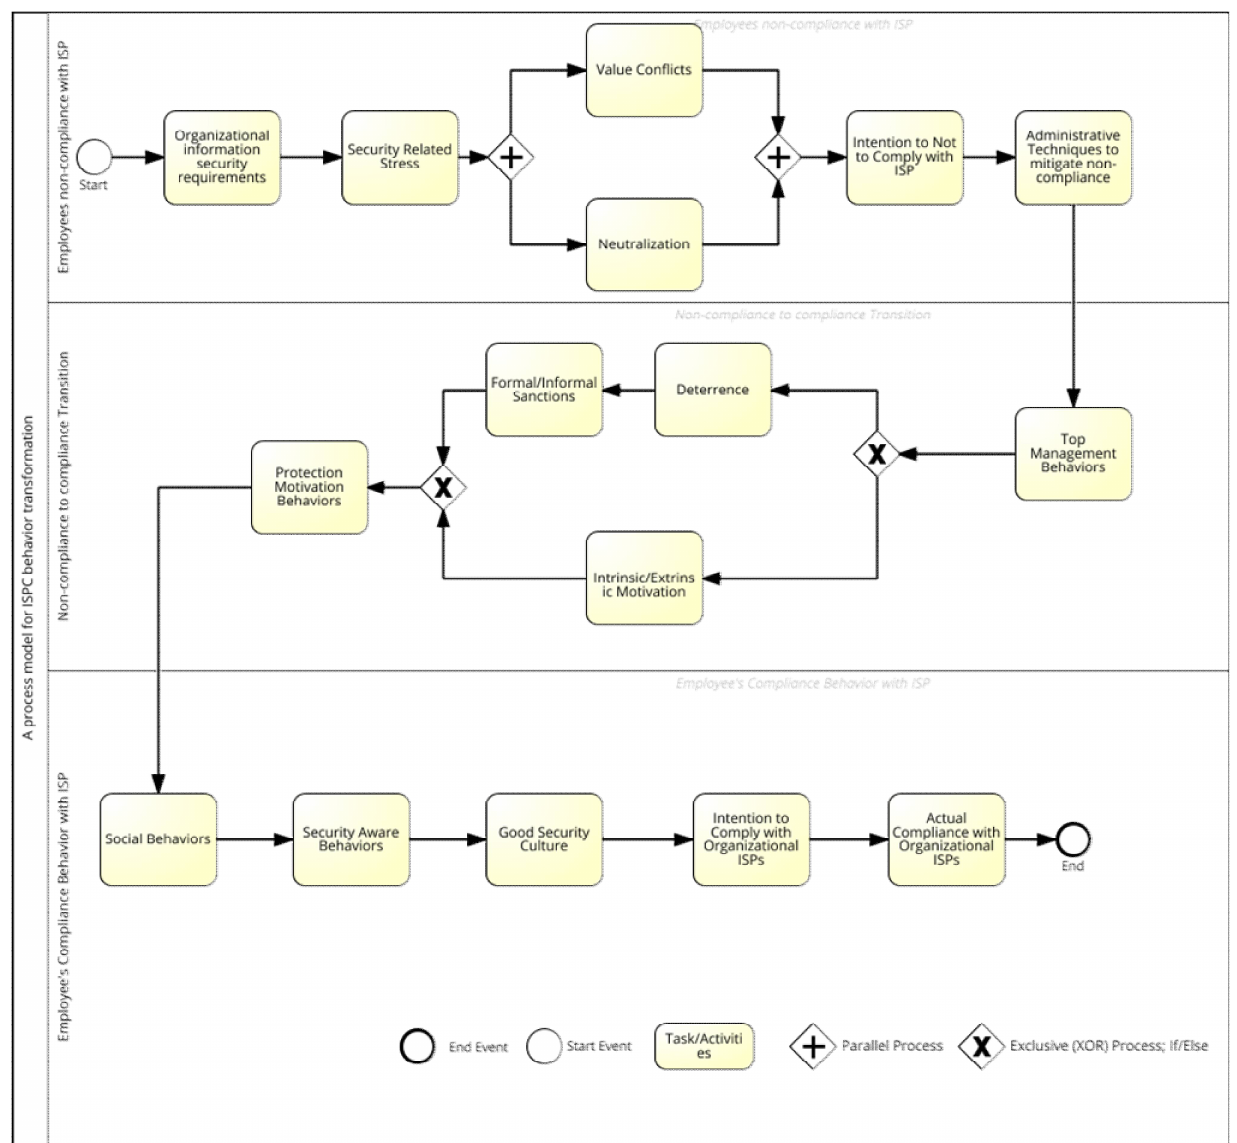
Figure 5. Behavior transformation from noncompliance to compliance with ISP.